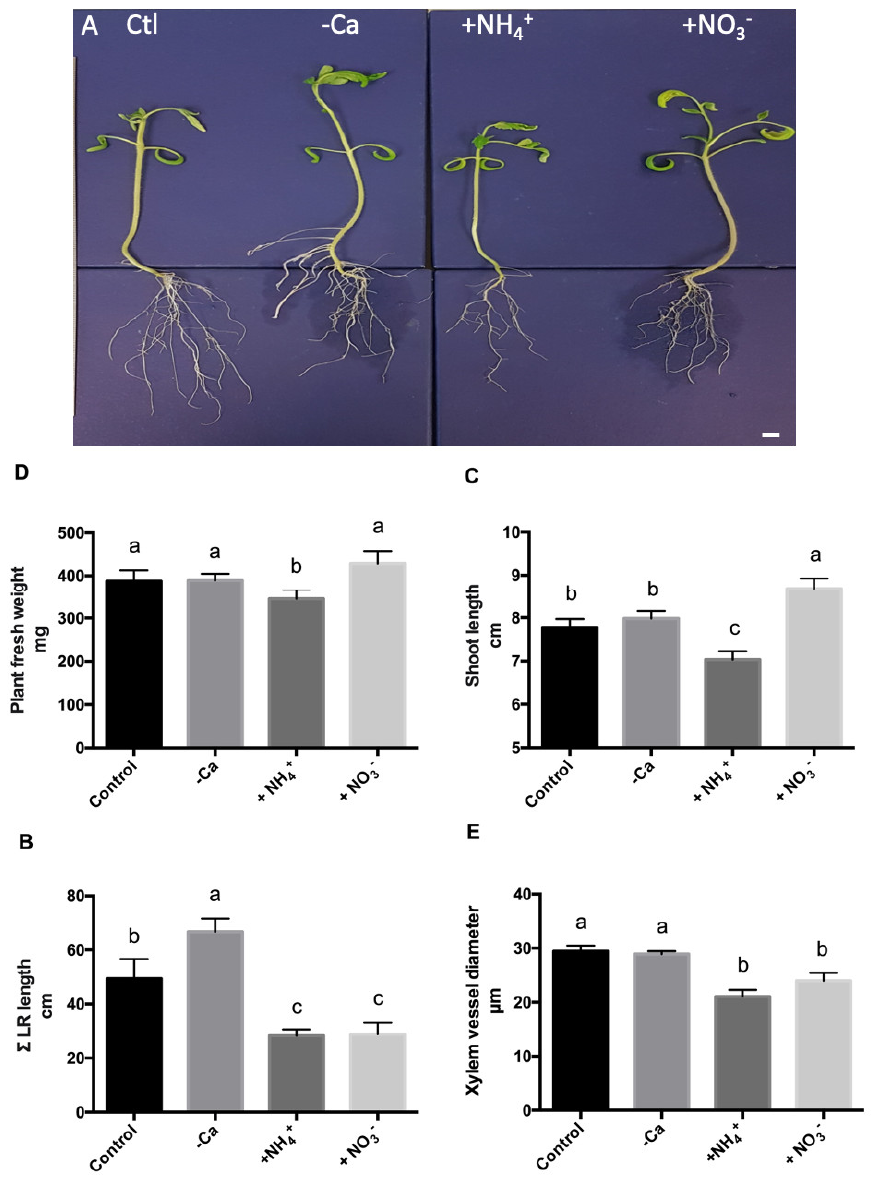
Figure 1. Tomato seedling response to calcium deficit or ammonium and nitrate excesses in in vitro experiment. Tomato seedlings were grown with control media, with a calcium deficit, or with ammonium or nitrate excesses for 10 days in a growth chamber as described in the Materials and Methods section. Tomato images were taken 10 days after sowing the seedlings: ( A ) representative image of seedlings; ( B ) sum of lateral root length; ( C ) shoot length; and ( D ) plant fresh weight. Xylem vessel diameters ( E ) were measured by light microscopy (40 × ). a, b, c represents statistically significant differences with p <